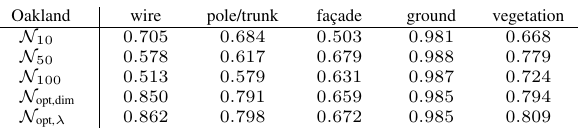
Table 4: Recall values for RF-based classification using all fea- tures and different neighborhood definitions.